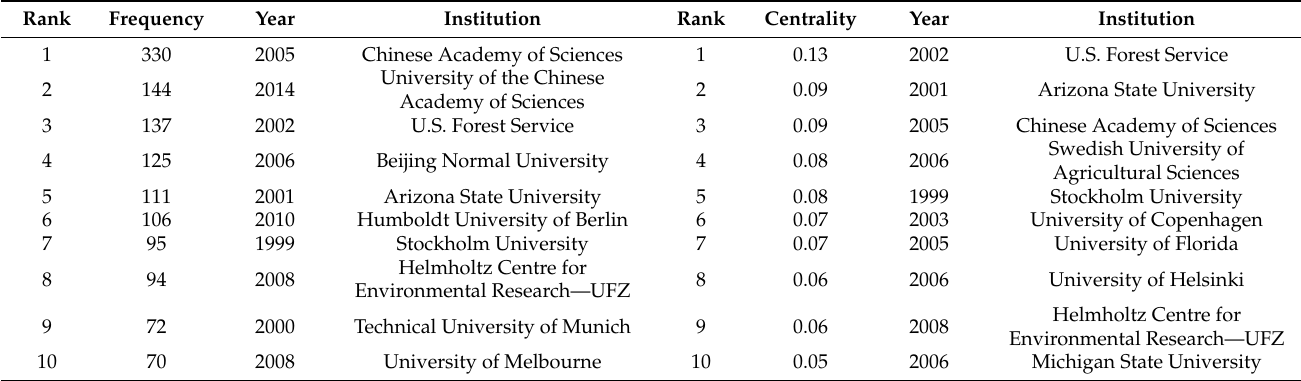
Table 4. Contributing institutions by frequency and